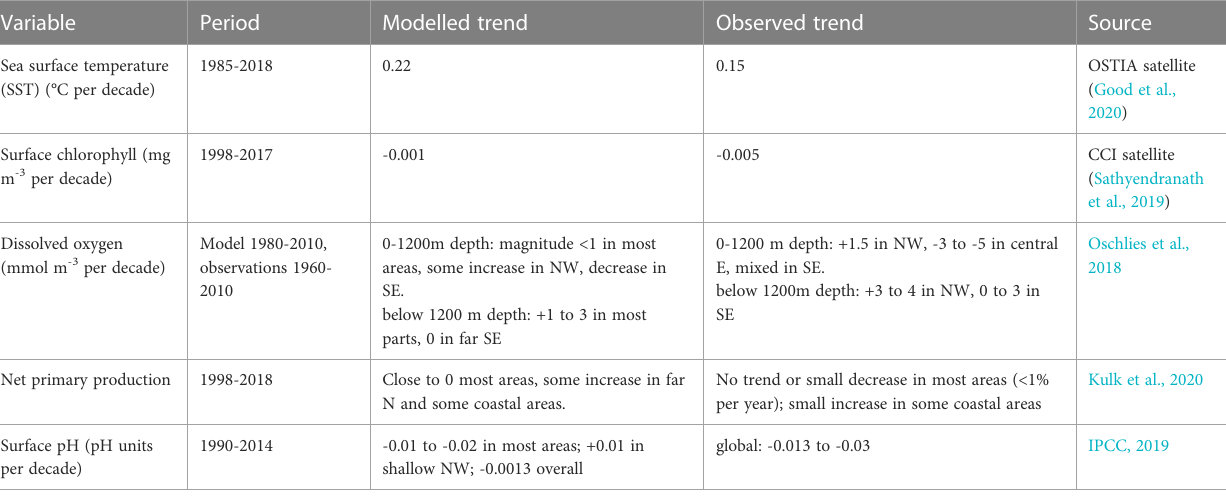
TABLE 1 Comparison of modelled and observed past trends in selected variables.